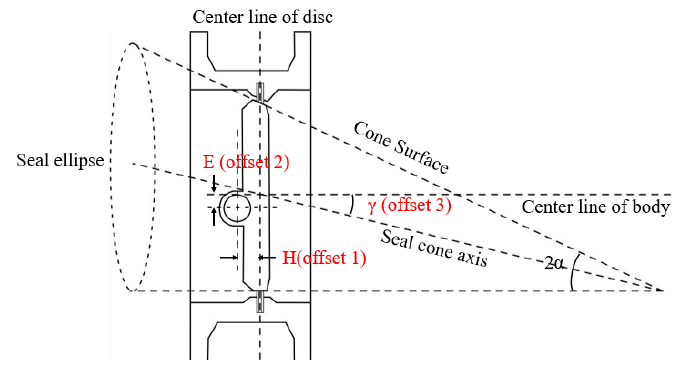
Figure 5. Scheme of the triple-offset butterfly valve.